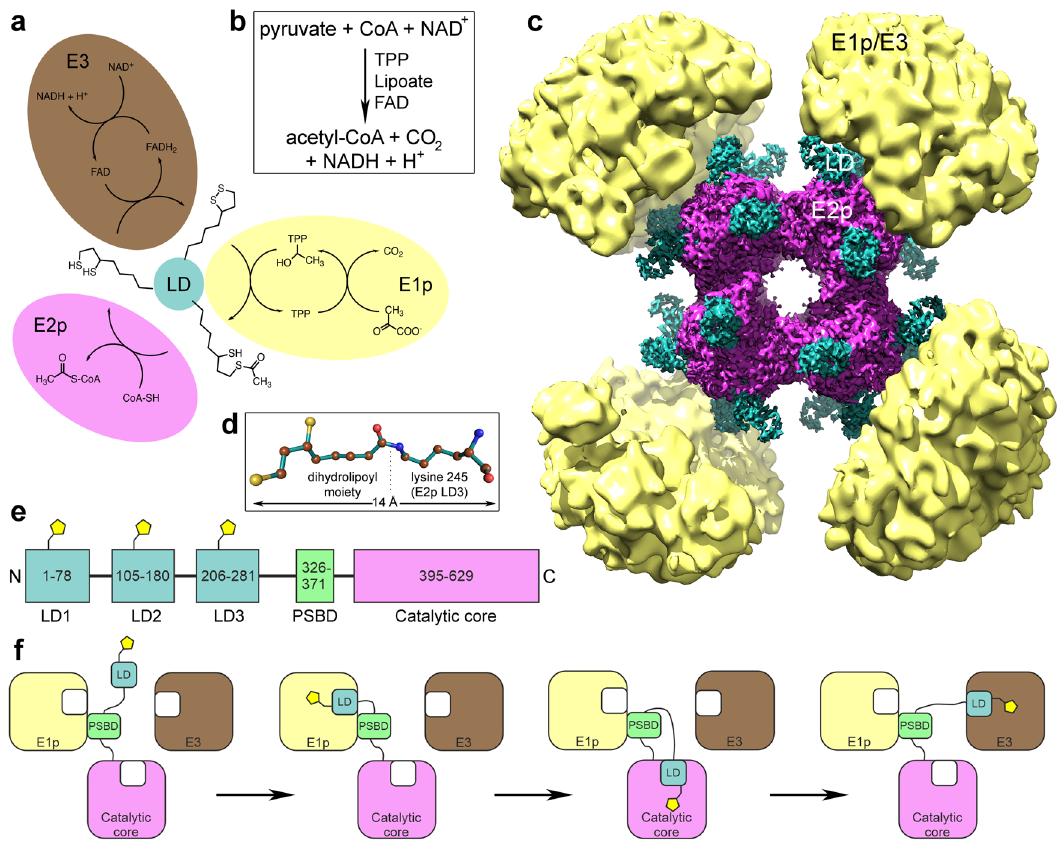
Fig. 1 Reaction mechanism and cryo-EM reconstruction of E. coli PDHc. a Scheme of the reactions catalyzed by the individual components of PDHc. b Overall reaction catalyzed by PDHc. c High-resolution cryo-EM reconstruction of the inner E2p core in alignment with the low-resolution reconstruction of the outer shell of the complex. Catalytic cores of E2p are colored magenta, lipoyl domains cyan, and the outer shell components (E1p/E3) yellow. d Ball- and-stick representation of the dihydrolipoyllysine moiety. e Scheme of the domain organization of E2p. f A simpli fi ed scheme of the covalent swinging-arm substrate channeling mechanism in the catalytic cycle of PDHc. Only one LD is shown and only one copy of each enzyme is shown, but the LDs can reach multiple copies of each enzyme in the multienzyme complex. PSBD can bind to either E1p or E3. E1p — pyruvate dehydrogenase, E2p — dihydrolipoyl transacetylase, E3 — dihydrolipoyl dehydrogenase, LD — lipoyl domain, PSBD — peripheral subunit-binding domain. Panels d – f were prepared based on Arjunan et al. 19